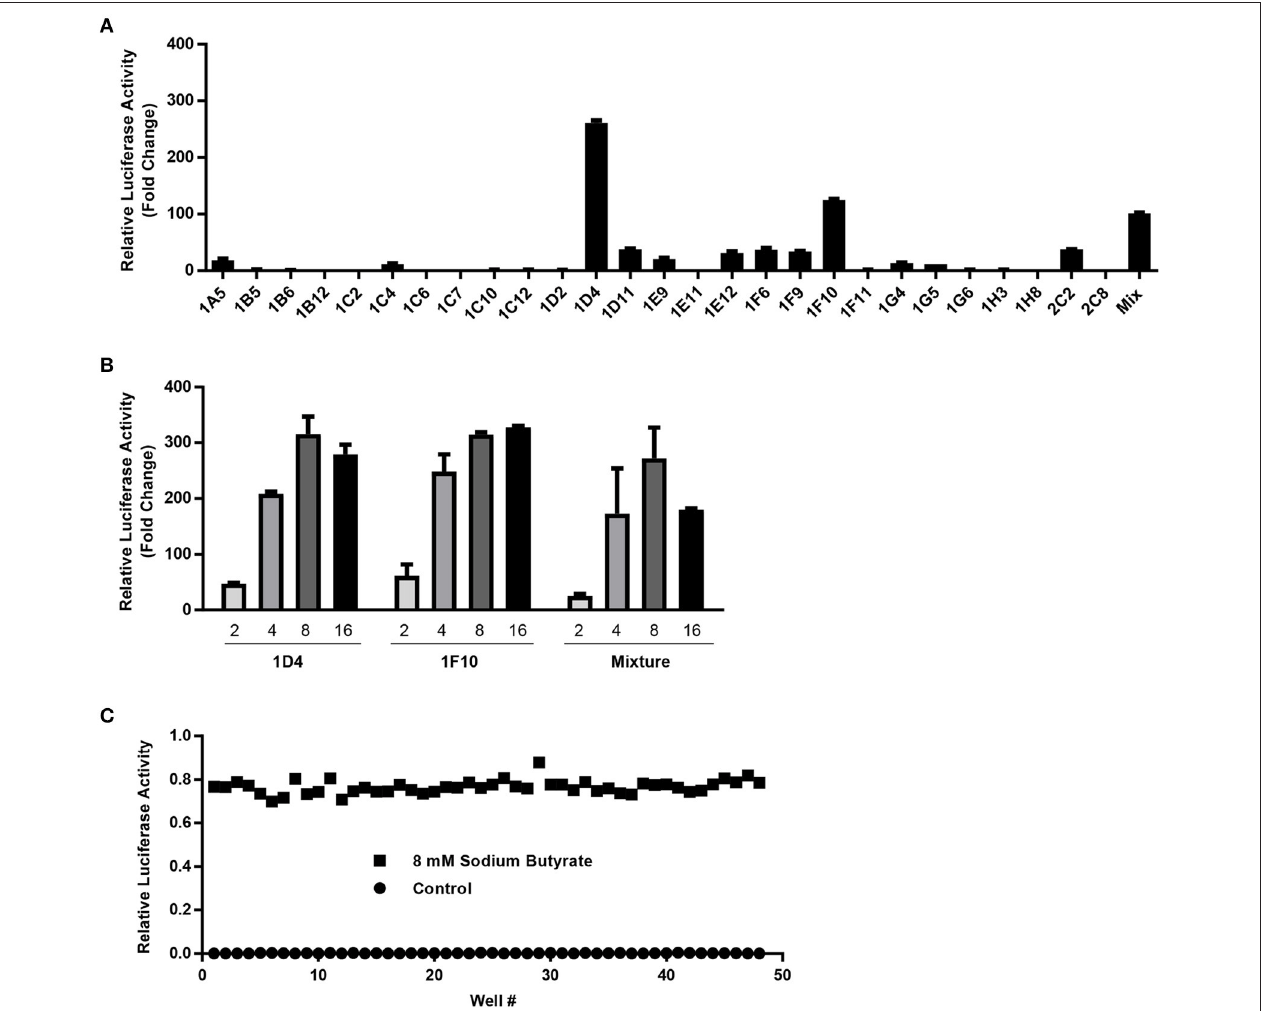
FIGURE 2 | Characterization and optimization of stable HTC/ AvBD9-luc luciferase reporter cells for high-throughput screening. (A) The fold change in luciferase activity of each cell clone in response to 8mM butyrate relative to that of non-stimulation control. (B) Dose-dependent response of two selected stable cell clones and stable cell mixture to sodium butyrate (mM). The results in (A,B) are means ± SEM of two independent experiments. (C) Relative luciferase activities of stable reporter cells in the presence or absence of 8mM sodium butyrate for calculation of the Z’-factor.